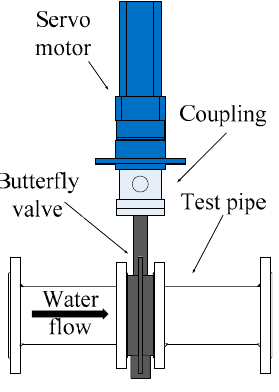
Figure 8. Diagram of the flow fluctuation generator.